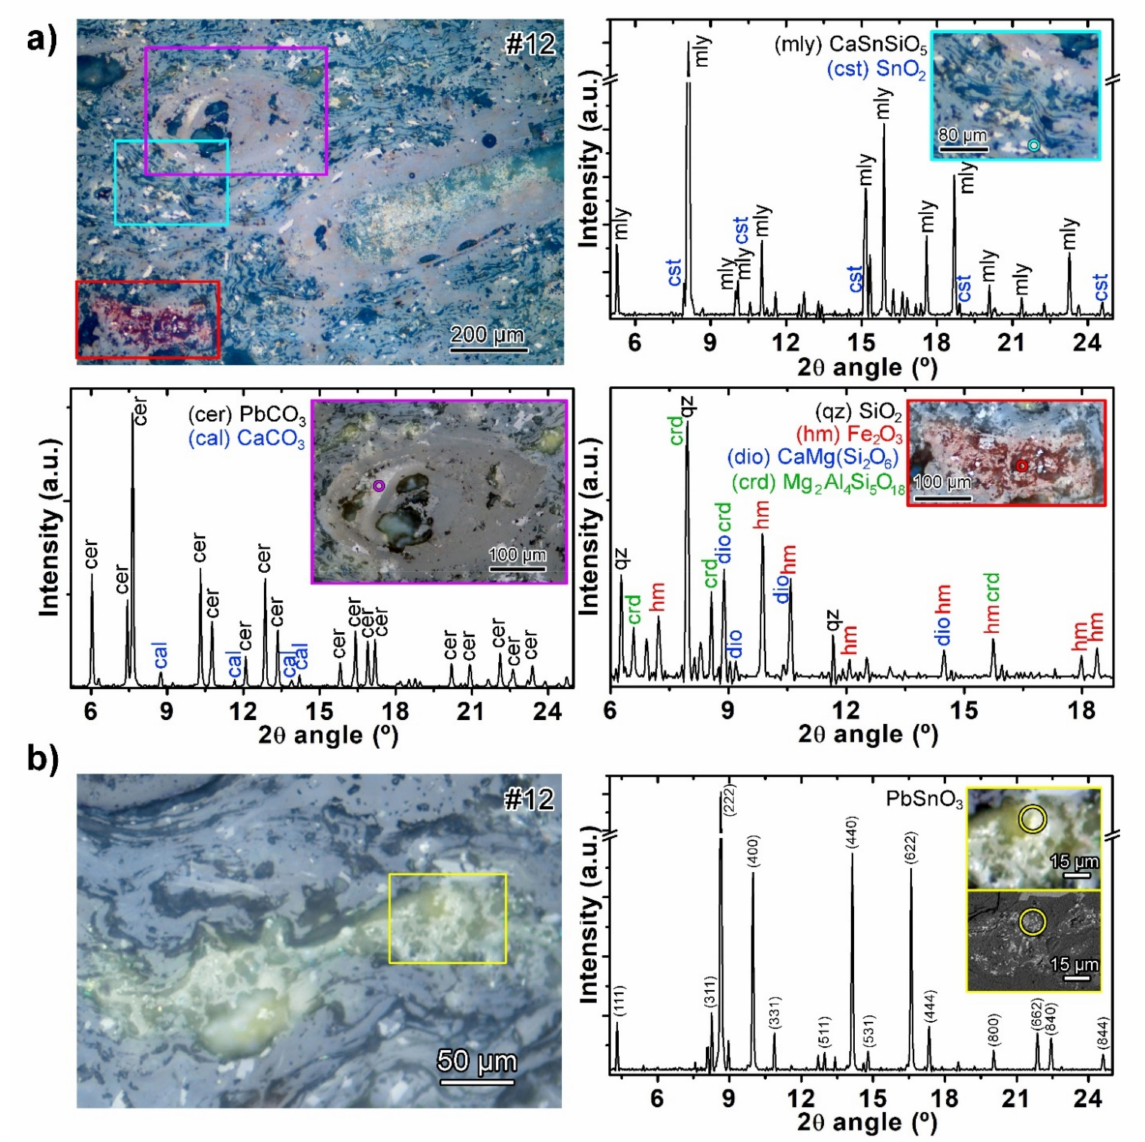
Figure 11. Representative diffractograms obtained by SR tts- µ XRD from the crystalline features found within the green glass tessera #12: ( a ) POM image in RL mode with several highlighted colored rectangles, also shown as insets in the diffraction patterns, where the corresponding irradiated areas are marked with circles: (( right ) grayish reflectance crystals including malayaite (mly) and cassiterite (cst), ( bottom-left ) pore filling including cerussite (cer) and calcite (cal); ( bottom-right ) reddish relict clod including quartz (qz), hematite (hm), diopside (dio) and cordierite (crd)). ( b ) POM image in RL mode with a highlighted rectangle, also shown as an inset (along with the equivalent SEM image) in the diffraction pattern on the right, where the corresponding irradiated area is marked with a circle, they correspond to yellowish reflectance crystals of cubic PbSnO 3